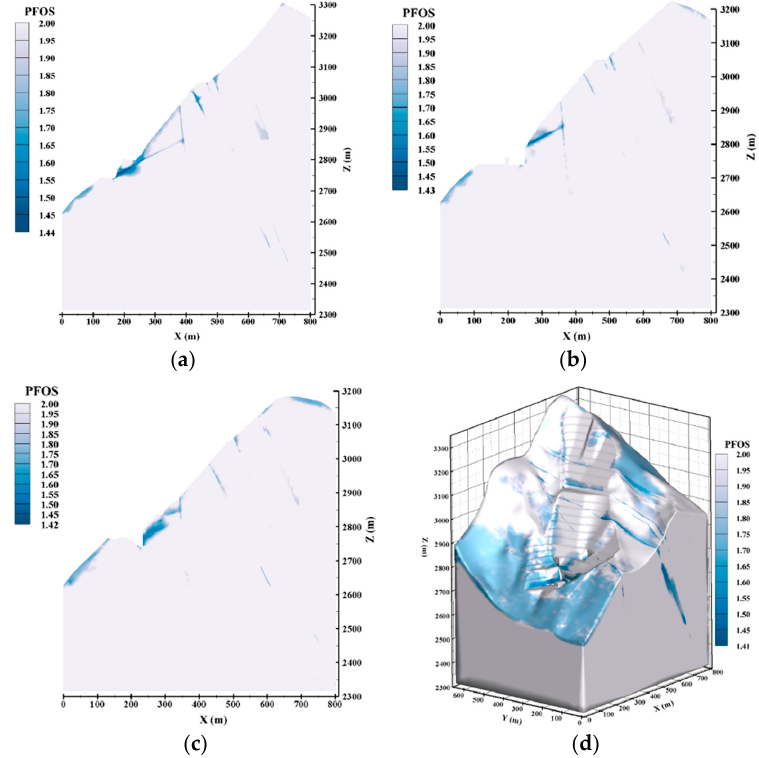
Figure 6. Transverse riverward displacement distribution of slope under condition I. ( a ) Profile 5; ( b ) profile 10; ( c ) profile 13; ( d ) entire body.